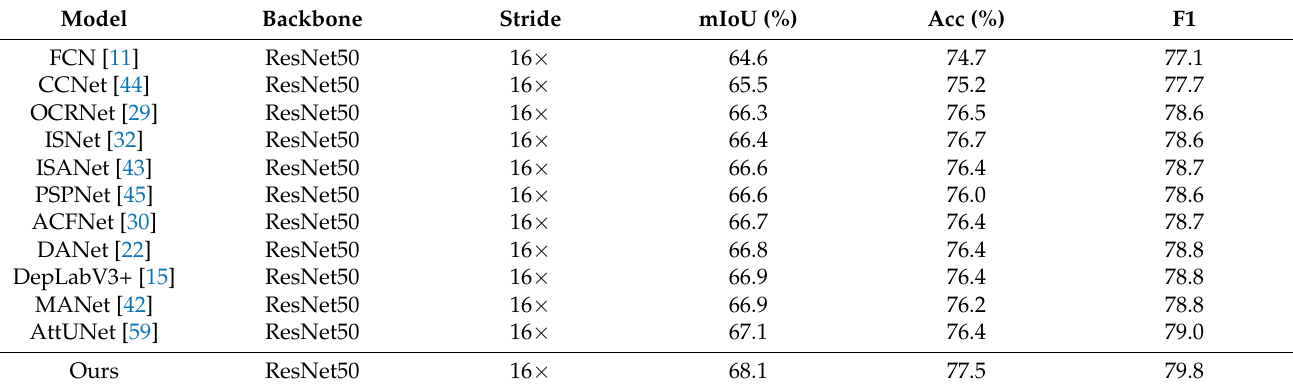
Table 7. Quantitative comparisons with state-of-the-arts on Vaihingen test set.